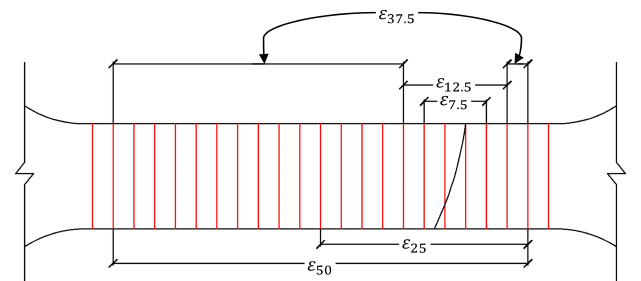
Figure 3. Elongations measured at various gauge lengths.